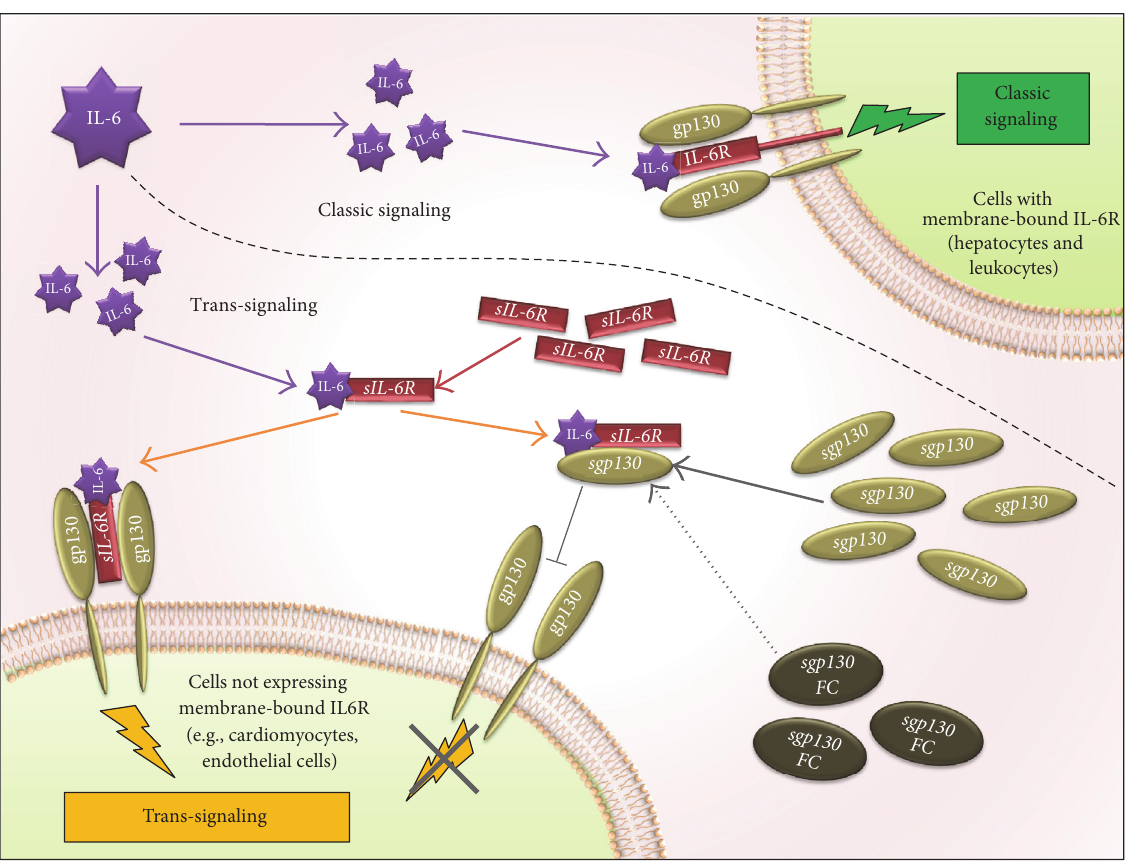
Figure 1: IL-6 signal transduction via classic and trans-signaling. The upper part of the figure depicts IL-6 signaling in cells expressing the membrane-bound receptor for IL-6 (IL-6R). In these cells (e.g., hepatocytes and several white blood cells), circulating IL-6 binds directly to IL-6R that forms a signaling complex with the membrane-bound glycoprotein 130 (gp130); this pathway is known as classic signaling. The bottom part depicts the IL-6 signaling in those cells that do not express the membrane-bound IL-6R. In these cells, membrane-bound gp130 (ubiquitously expressed) is activated by the circulating IL-6/sIL-6R complex (composed of IL-6 and the circulating soluble portion of IL-6R, sIL-6R). This pathway, known as trans-signaling, could be inhibited by the circulating soluble portion of gp130 (sgp130), which, by means of binding the circulating IL-6/sIL-6R complex, blocks the activation of the membrane-bound gp130. sgp130fc is a recombinant fusion protein of soluble gp130 and human IgG1 Fc that blocks IL-6 trans-signaling mimicking sgp130